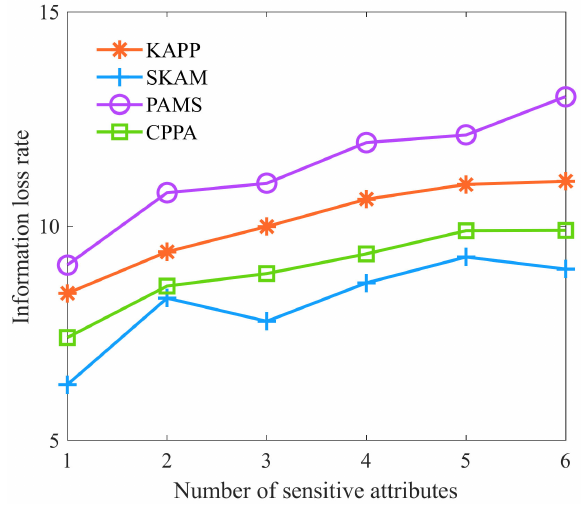
Figure 10. Anonymity of the different numbers of sensitive attributes.